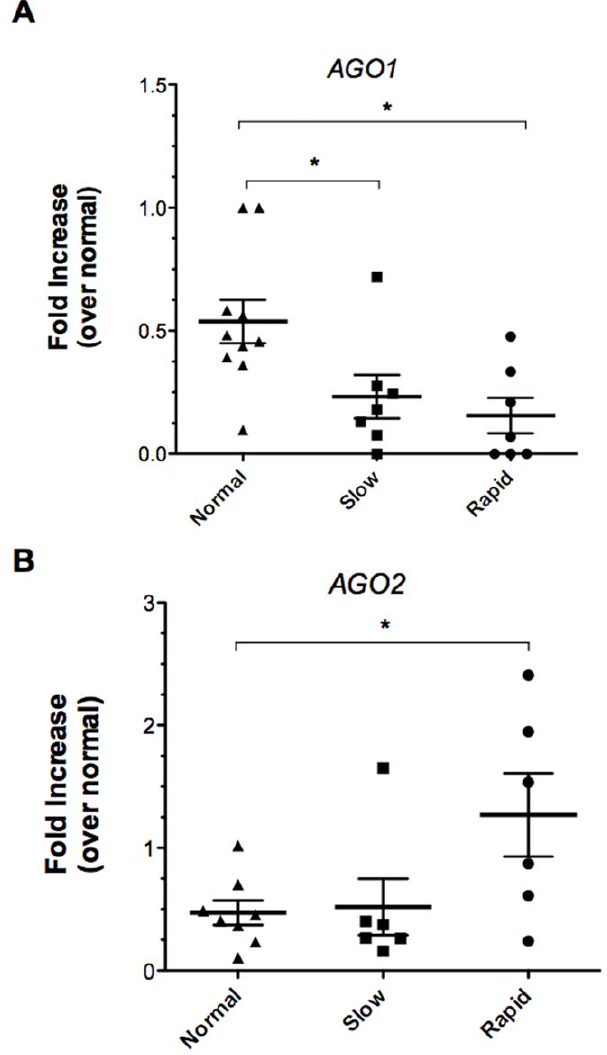
Figure 3. Differentially expressed transcripts of A) CD44 , B) COL1A2 , C) VIM , D) FOXC1 , E) FOXC2 , and F) FSCN1 in rapidly progressive IPF and slowly progressive lung biopsies versus normal biopsies. Total RNA from SLBs was analyzed by qRT-PCR for transcript expression. Relative expression values were normalized to the normal group (n=10) and compared to the slowly progressive (n=6) or rapidly progressive group (n=9). Expression values were also normalized to GAPDH. Data are presented as mean 6 SE. Significant differences are shown as *P # .05